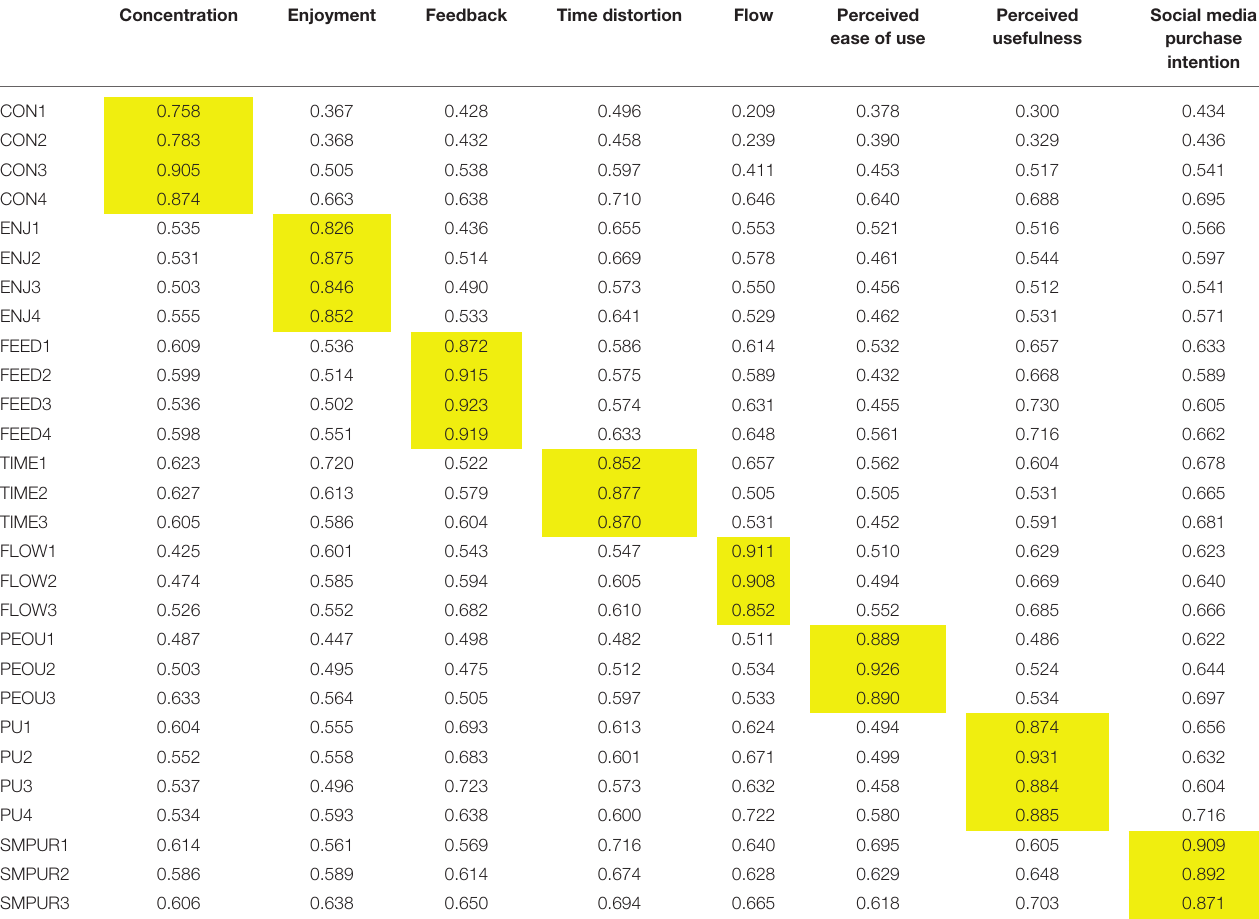
TABLE 2 | Standardized factor loadings and cross-loadings of the outer model. Concentration Enjoyment Feedback Time distortion Flow Perceived